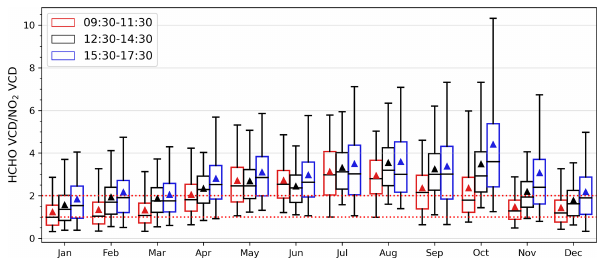
Figure 11. Monthly mean HCHO VCD / NO 2 VCD ratios (trian- gles) calculated from MAX-DOAS measurements for the morning (09:30–11:30LT, red), noon around the OMI overpass time (12:30– 14:30LT, black), and late afternoon (15:30–17:30LT, blue) over Mohali. The lines at the centres of the boxes represent the median; the boxes show the interquartile ranges whereas the whiskers show the 5th and 95th percentile